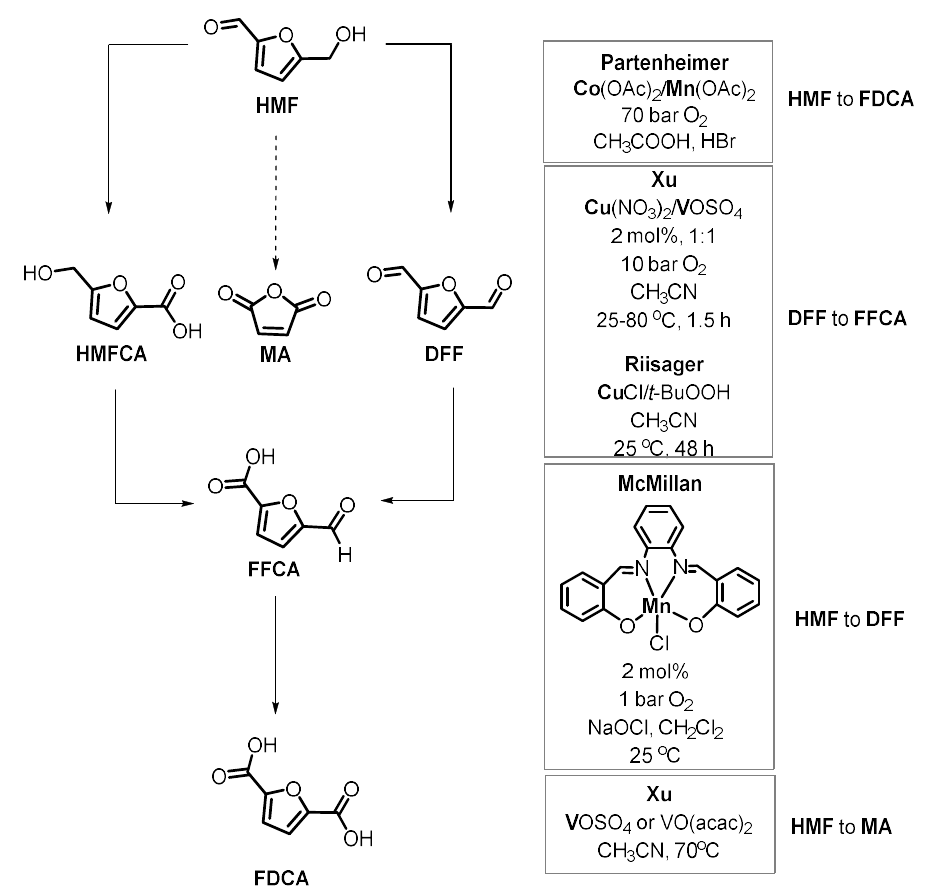
Figure 8. Methods of oxidation of furanics.